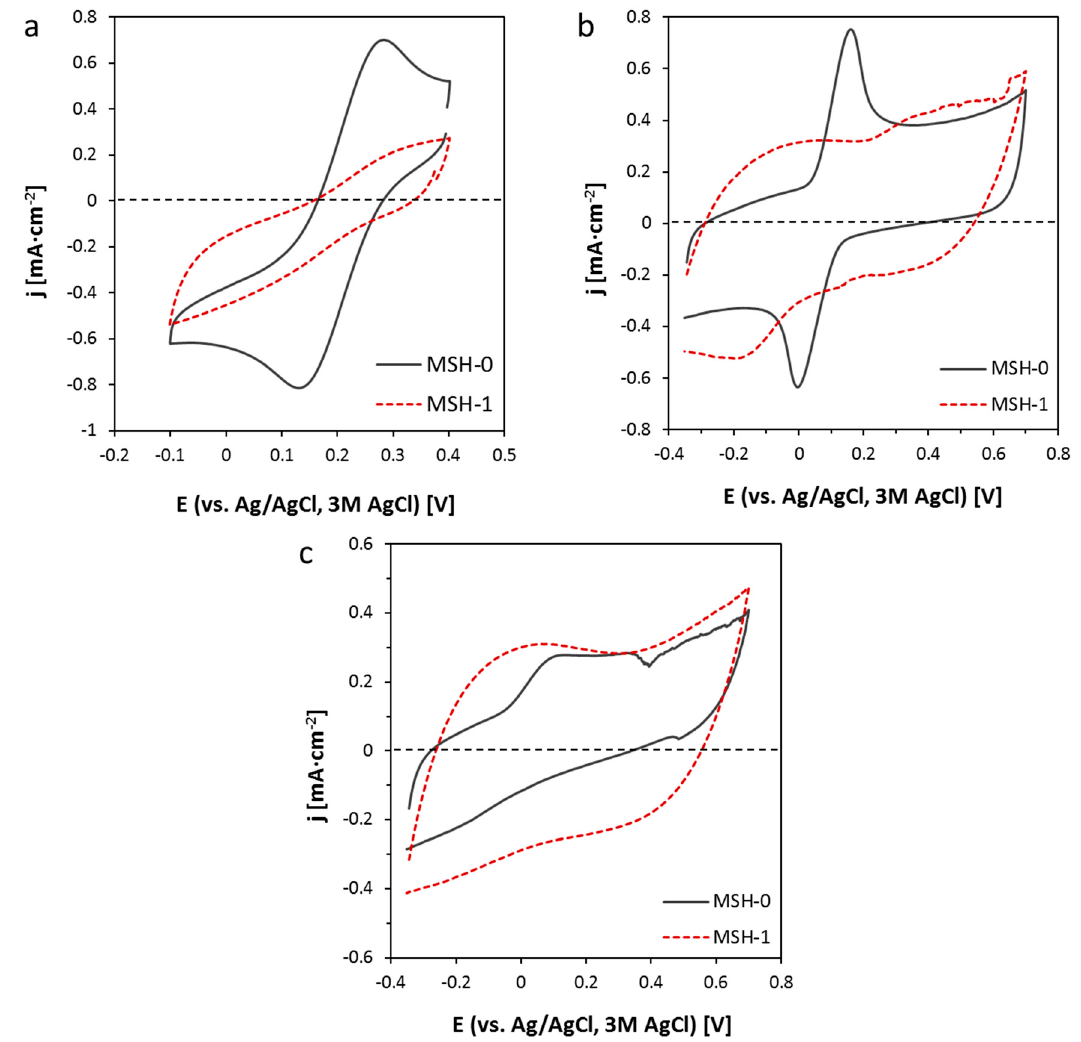
Figure 5. Cyclic voltammograms in the presence of three different redox couples: ( a ) K 3 Fe(CN) 6 /K 4 Fe(CN) 6 in 0.1M Na 2 SO 4 at 10 mV·s − 1 ; ( b ) hydroquinone in 0.1M phosphate buffer, pH = 6.85, at 20 mV·s − 1 ; ( c ) ascorbic acid in 0.1M phosphate buffer, pH = 6.85, at 20 mV·s − 1 .